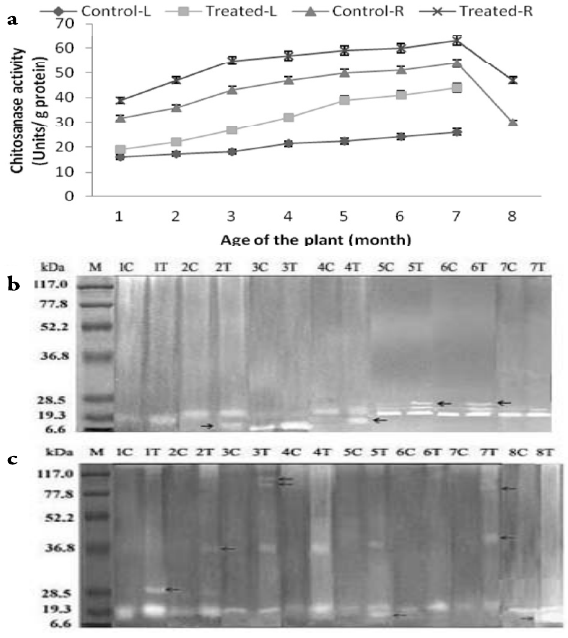
Fig. 2. Chitosanase activity (a) in control and treated turmeric plants (L- Leaf; R- Rhizome); Localization of chitosanase isoforms in leaves (a) and rhizomes (b) of turmeric on SDS-PAGE (10%) M - Marker protein standard (Bio Rad Chem. Co., USA); C - Control; T - Treated; 1 to 7 - age of the plant in month. Molecular weight of marker protein: 117.0 kDa- β -Galactosidase; 77.8 kDa- BSA; 52.2 kDa- Ovalbumin; 36.8 kDa- Carbonic anhydrase; 28.5 kDa- Soybean trypsin inhibitor; 19.3 kDa- Lysozyme; 6.6 kDa-